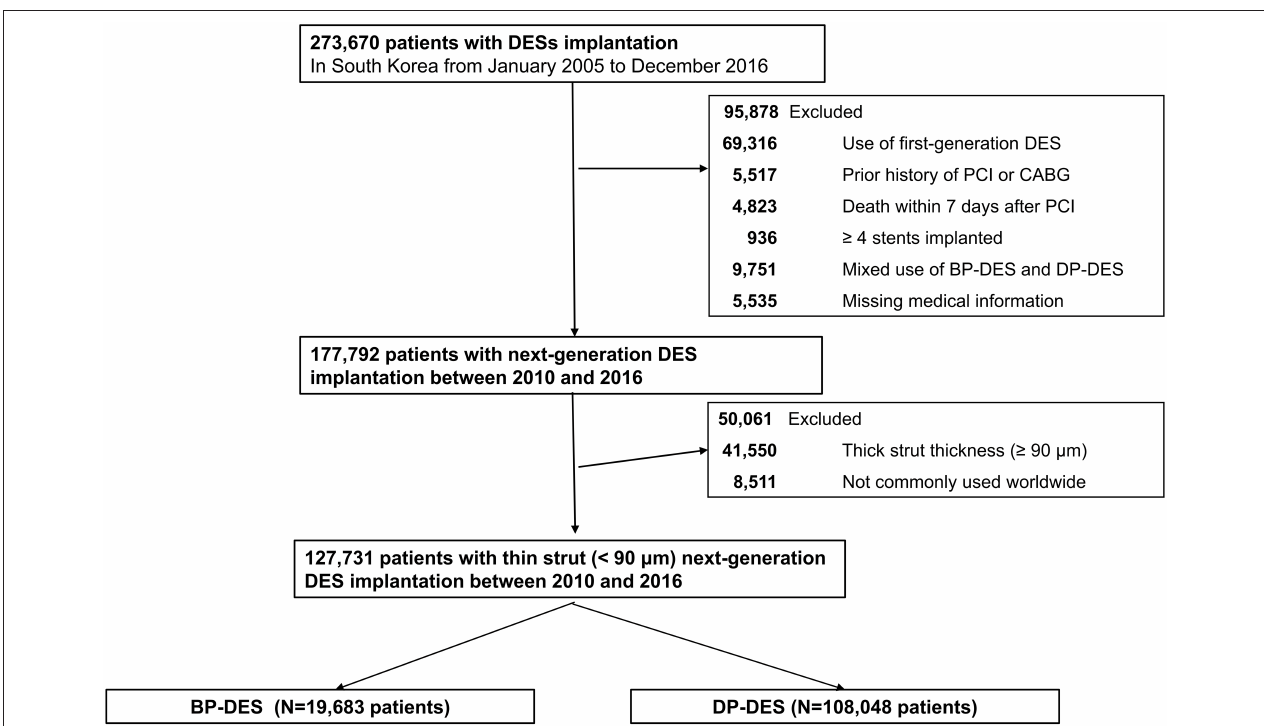
FIGURE 1 | A flowchart of study population. DES, drug-eluting stent; BP-DES, biodegradable polymer drug-eluting stent; CABG, coronary artery bypass graft; DP-DES, durable polymer drug-eluting stent; PCI, percutaneous coronary